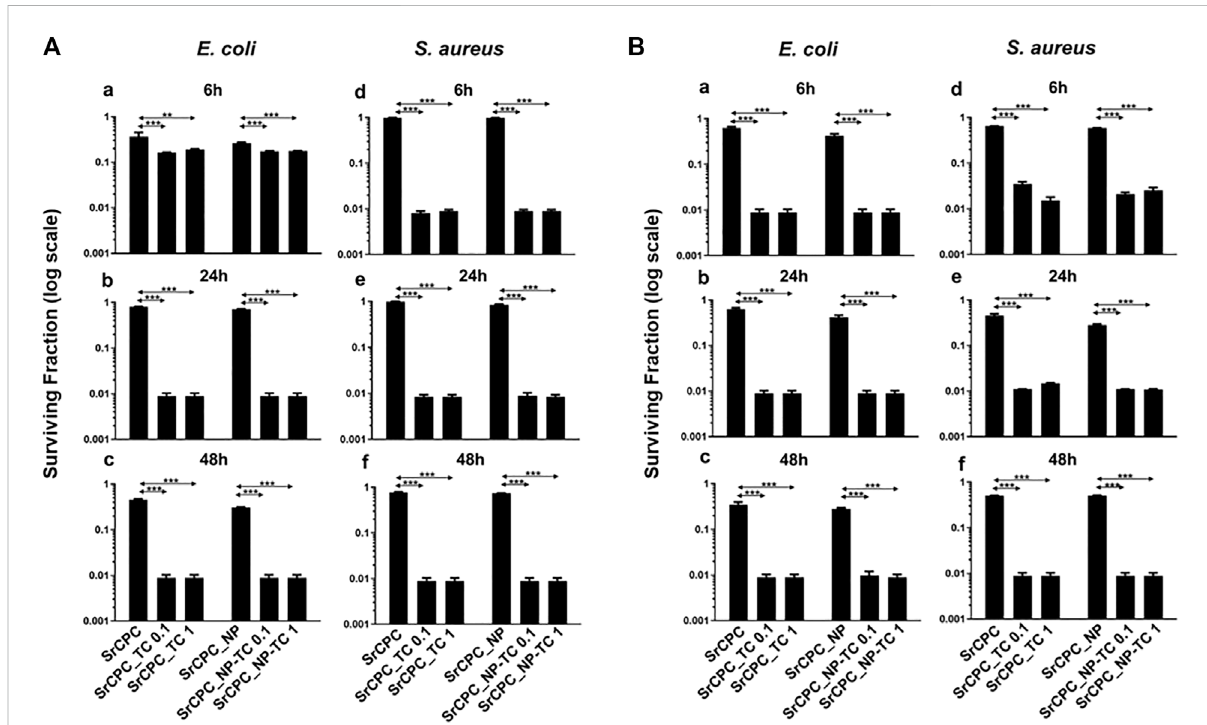
FIGURE 6 Bacterial viabilityof planktonic cultures (A) and adherent bacteria (B) to scaffold. E. coli (a – c) and S.aureus (d – f) were incubated throughdirect contactwithscaffoldsat37 ° Cfor6 h (a – d) ,24 h (b – e) and48 h (c – f) ,respectively. (A) TheviabilityofplanktonicbacteriawasevaluatedbyMTTassay as described in the materials and methods section; (B) After the removal of planktonic bacteria at each time point, the viability of attached cells was determined byMTTassay.The data(log scale)wererepresented asthesurviving fractionwhichisexpressedastheratioofthenumber ofviable bacteria incubated with each scaffold over the number of bacteria grown in LB medium (Ctrl). Bars indicate mean values SD of the mean of results from two experiments. Statistical signi fi cance between the doped apatitic bone cements of the same group and their relative undoped samples